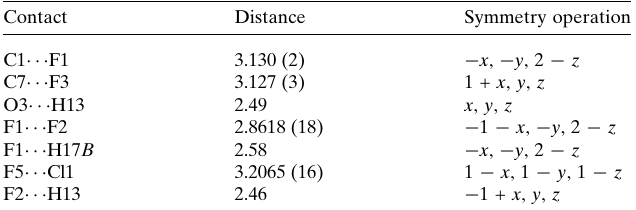
Table 2 Summary of short interatomic contacts (A˚ ) in (I) a . Contact